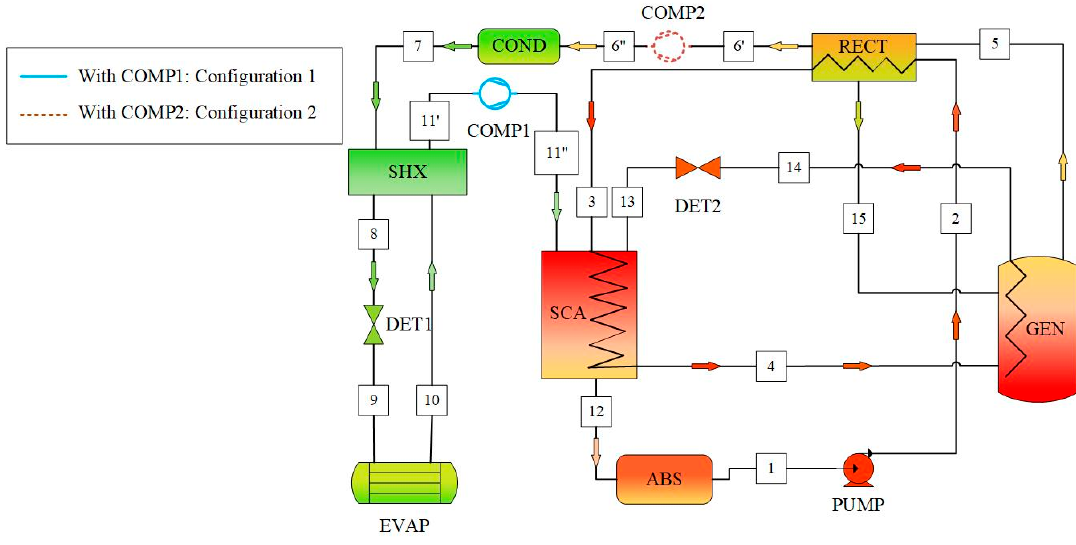
Figure 5. Schematic representation of hybrid cycles.